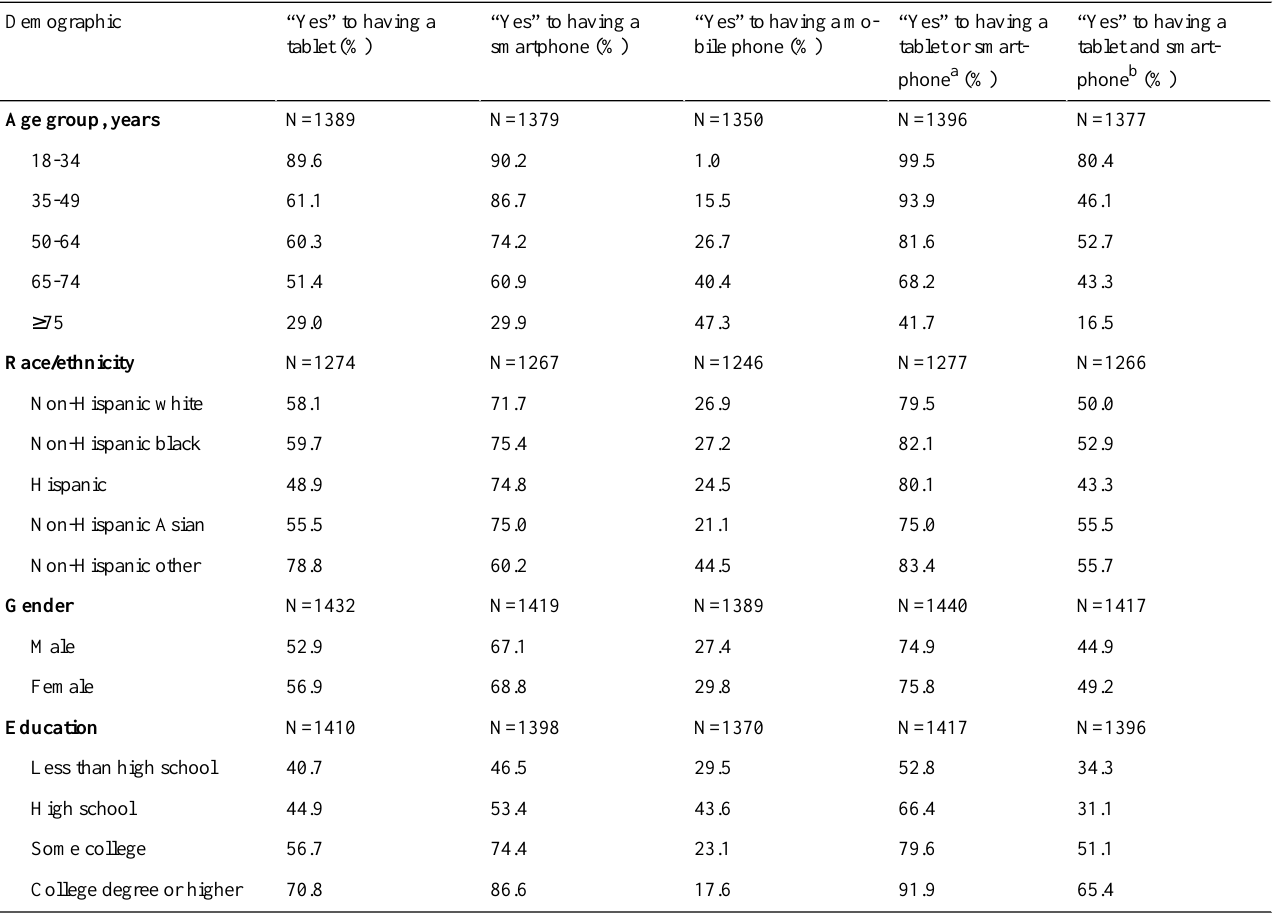
Table 2. Differences in device ownership and use among patients with hypertension according to demographics. Sample sizes reflect the number of participants with nonmissing values for device question and